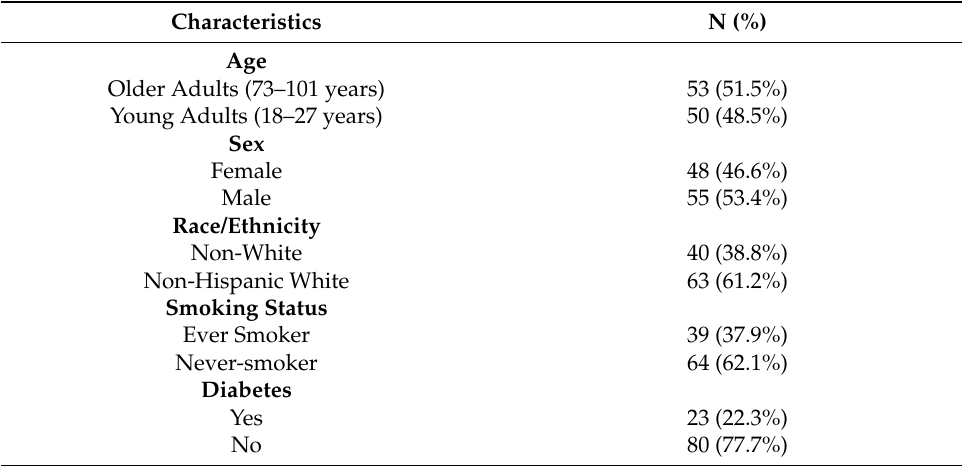
Table 1. Clinical and demographic characteristics of 103 adult subjects who underwent Dual Energy Computed Tomography (DE-CT).